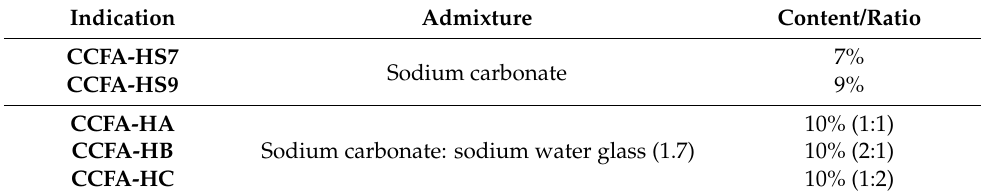
Table 7. The composition and indication of test samples for Phase 2 of the experiments. Indication